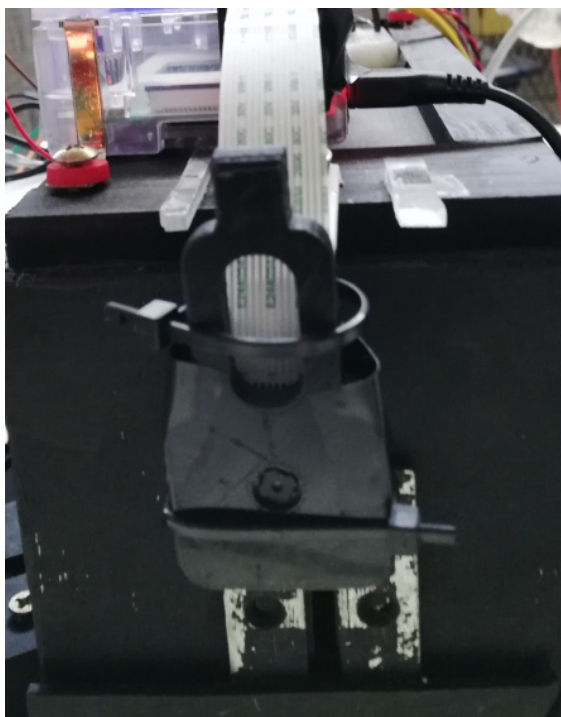
Figure 5. Front view of central camera B.